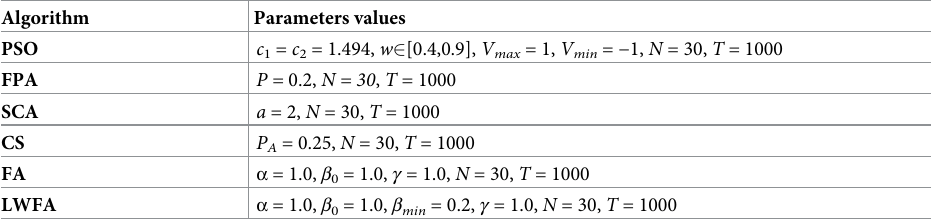
Table 4. The parameters of POS, CS, SCA, FPA, FA,